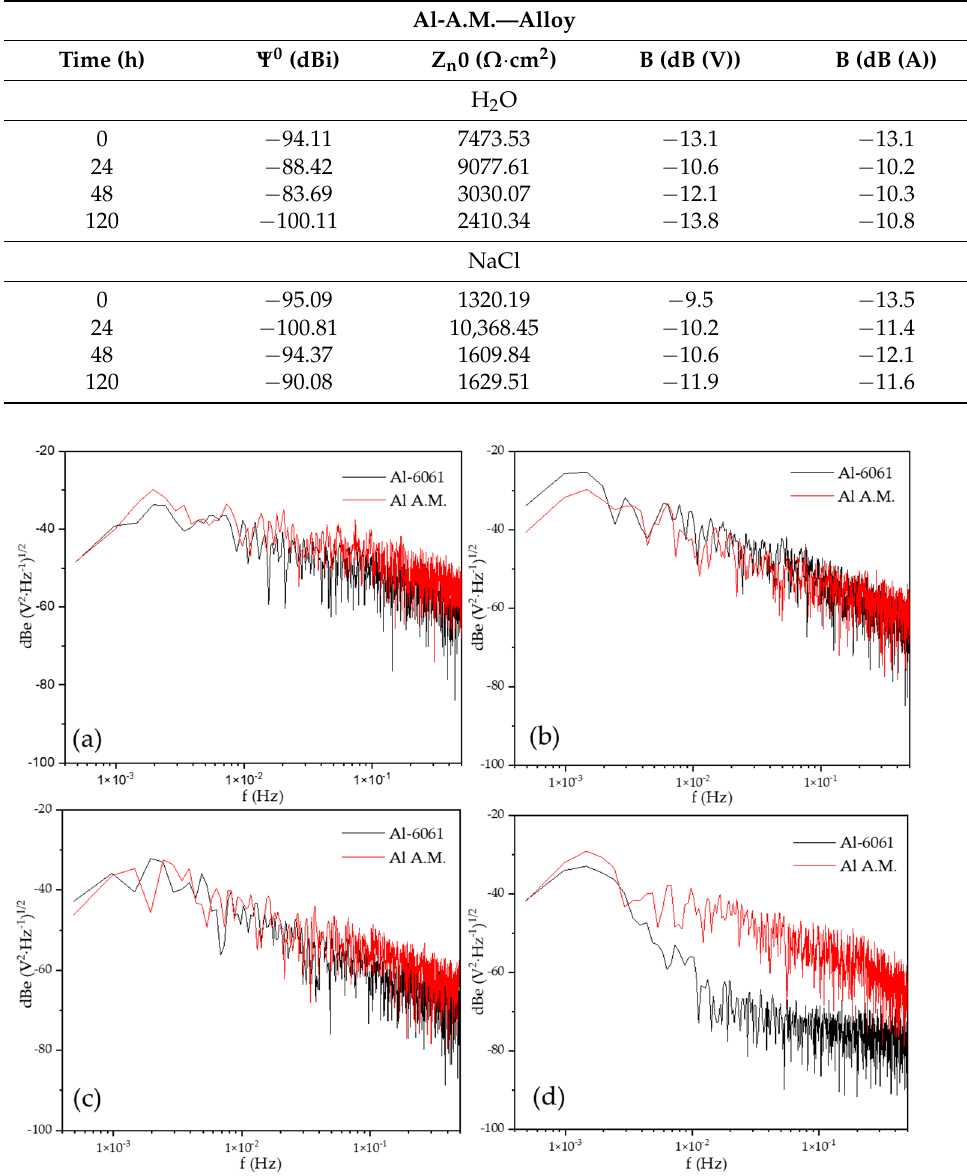
Figure 8. Power spectral density (PSD) in voltage in NaCl solution, ( a ) 0 h, ( b ) 24 h, ( c ) 48 h, and ( d ) 120 h.